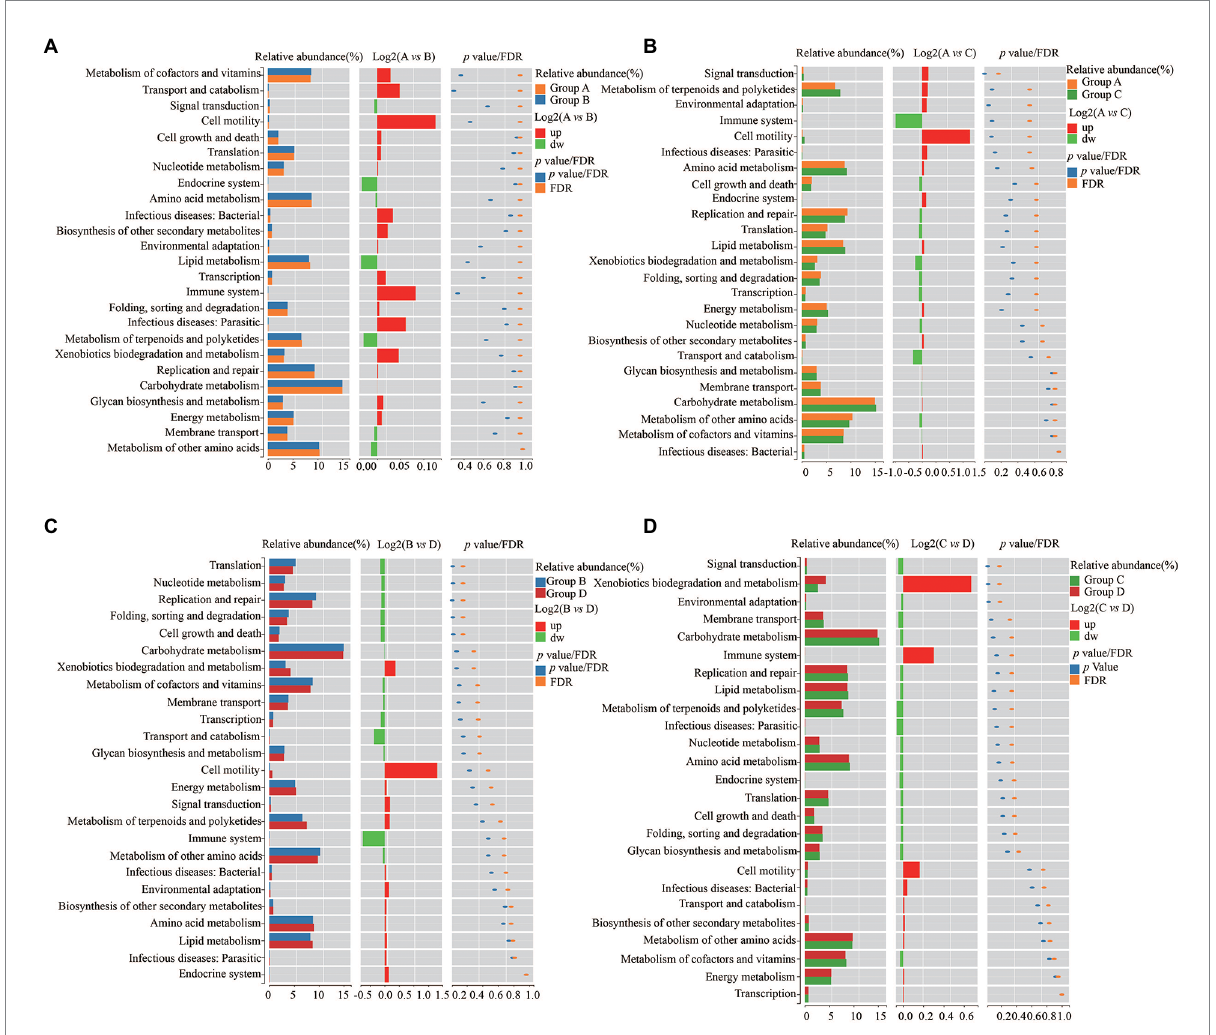
FIGURE 6 Differences of KEGG bacterial functions between Group A and Group B (A) , Group C and Group D (B) , Group A and Group C (C) , and Group C and Group D (D) ,